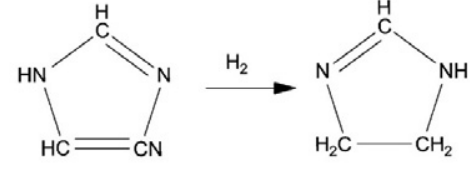
Figure 1. Structure of imidazole, imidazoline